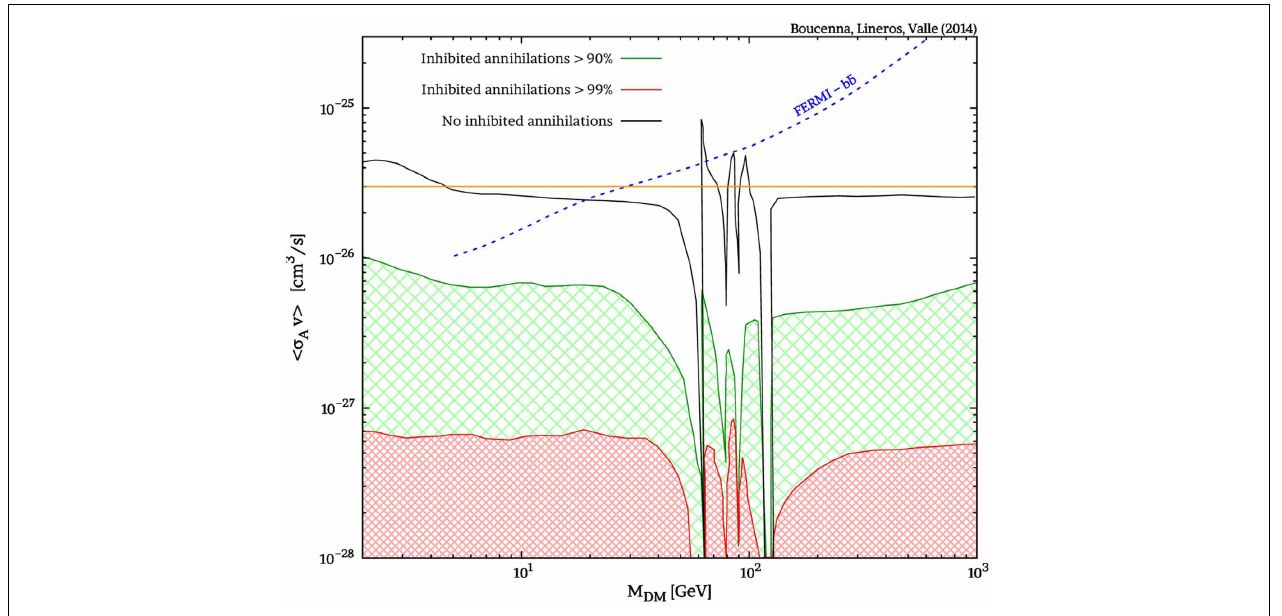
above 90 and 99% is illustrated by the green and red shaded regions, respectively. The thermal cross section = 3 × 10 − 26 cm 2 / s and FERMI’s constraints for annihilation (cid:3) σ v (cid:4) f . o . into b ¯ b are also